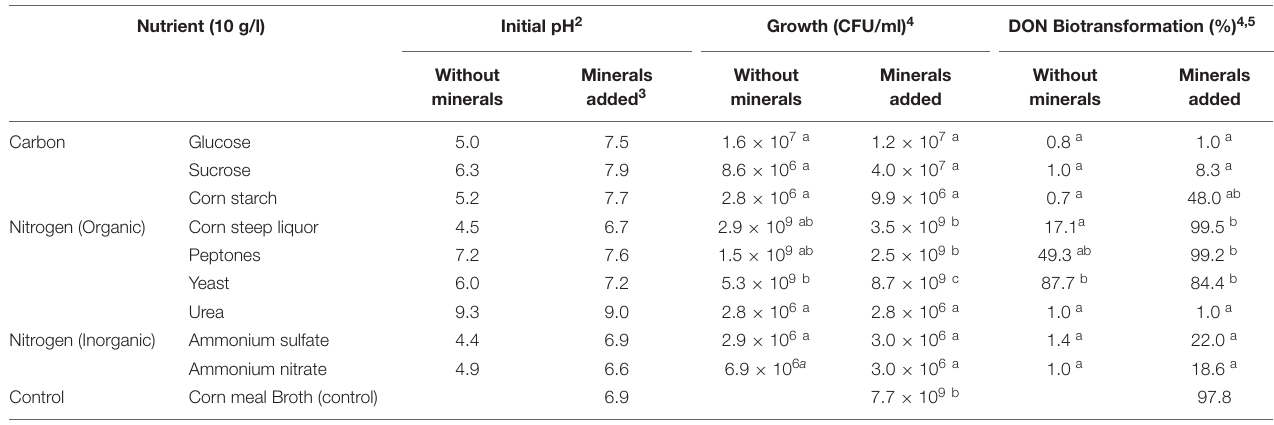
TABLE 4 | The effect of carbon, nitrogen, and minerals sources on growth and DON biotransformation activity of Devosia mutans Strain 17-2-E-8 1 . Nutrient (10